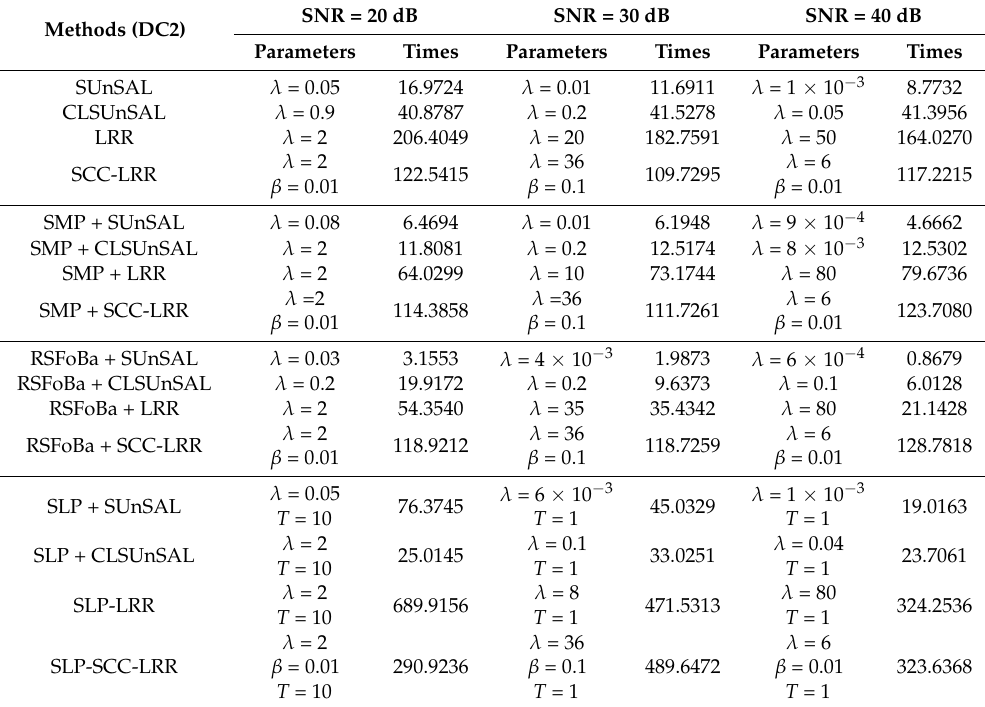
Table 4. The optimal parameters settings and running times(s) with the Simulated DATA